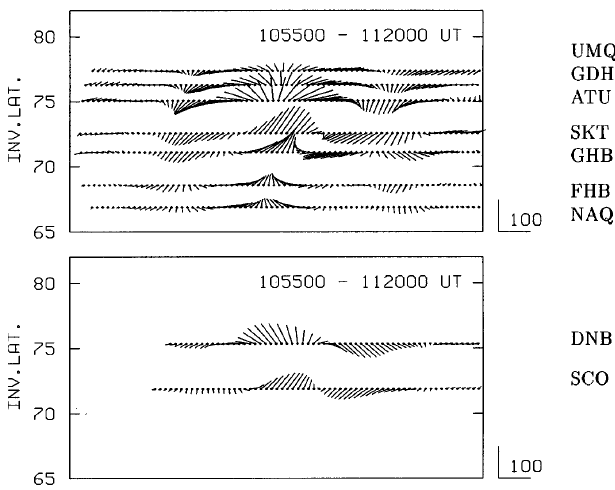
Fig. 1. Time-series of equivalent convection vectors (in units of nT) for the interval 1055 - 1120 UT on September 19, 1990. The top frame display the data of the West Greenland chain of stations (IAGA codes right, and Invariant Latitude left) and the bottom frame is for the East Greenland stations. The displacements between the starting points reflect the distribution of the stations in MLT, 20 sec (cid:25) 0.2 h of MLT, that is assuming a velocity of 4–6